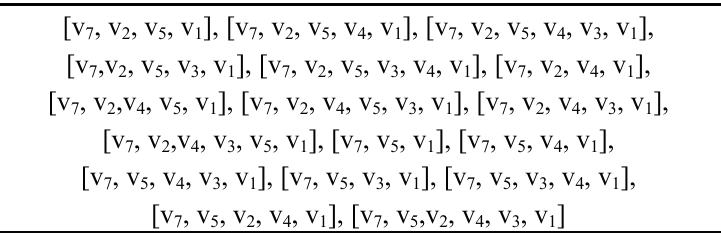
to node (cid:1874) (cid:2875)